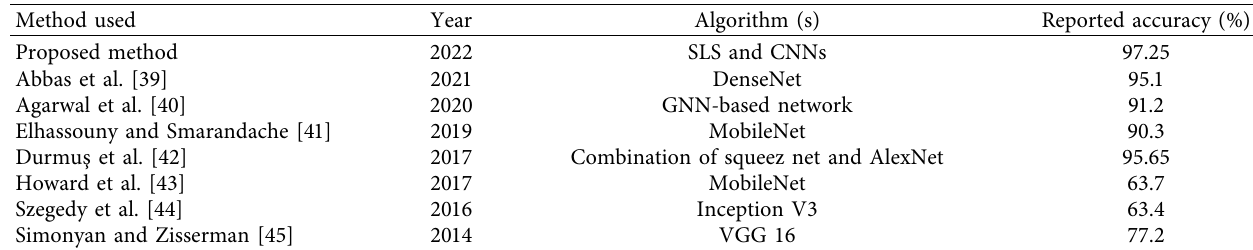
Table 7: Reported results and their comparison with previous